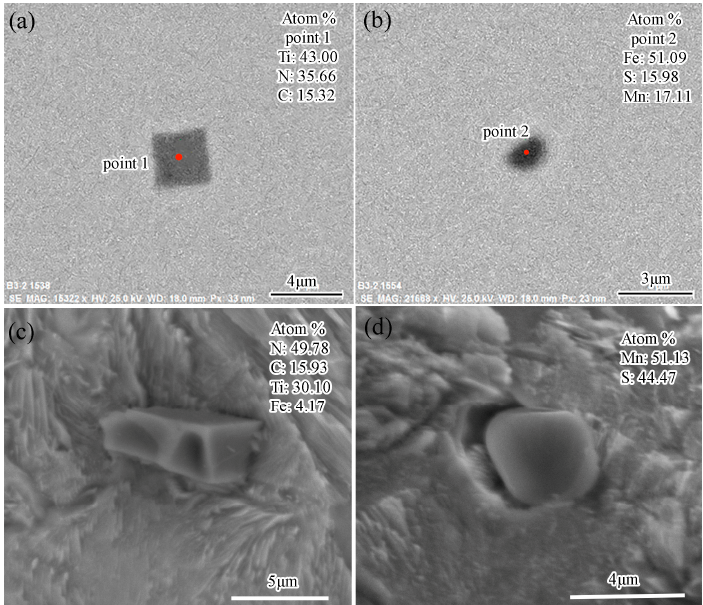
Figure 6. Typical morphologies of inclusions in steel 1 and steel 2. ( a , c ) Ti(C, N); ( b , d ) MnS.